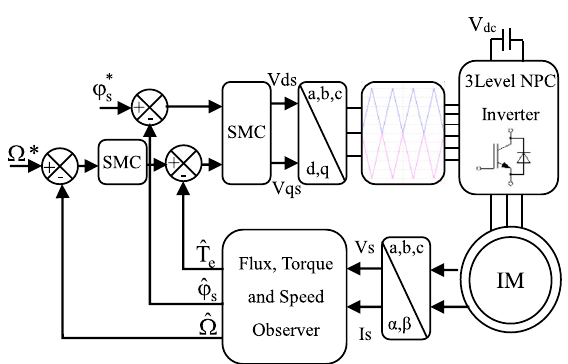
Fig. 1 General diagram of the SM-DTC method applied to an asynchronous motor supplied by a three-level inverter with a sliding mode observer